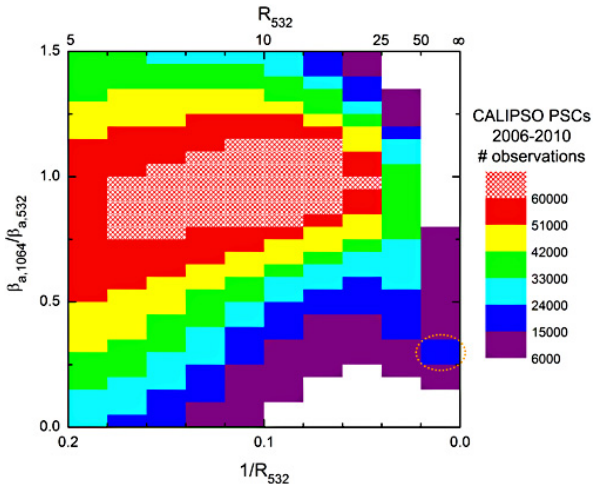
Fig. 2. Composite 2-D histogram of lidar color ratio ( β a , 1064 / β a , 532 ) vs. 1/ R 532 (with a bin size of 0.05 × 0.02) for CALIPSO PSC observations with 1/ R 532 < 0 . 2 from June 2006 to March 2010. Dashed red circle indicates abrupt shift in color ratio associated with wave clouds at 1/ R 532 < 0 . 02.